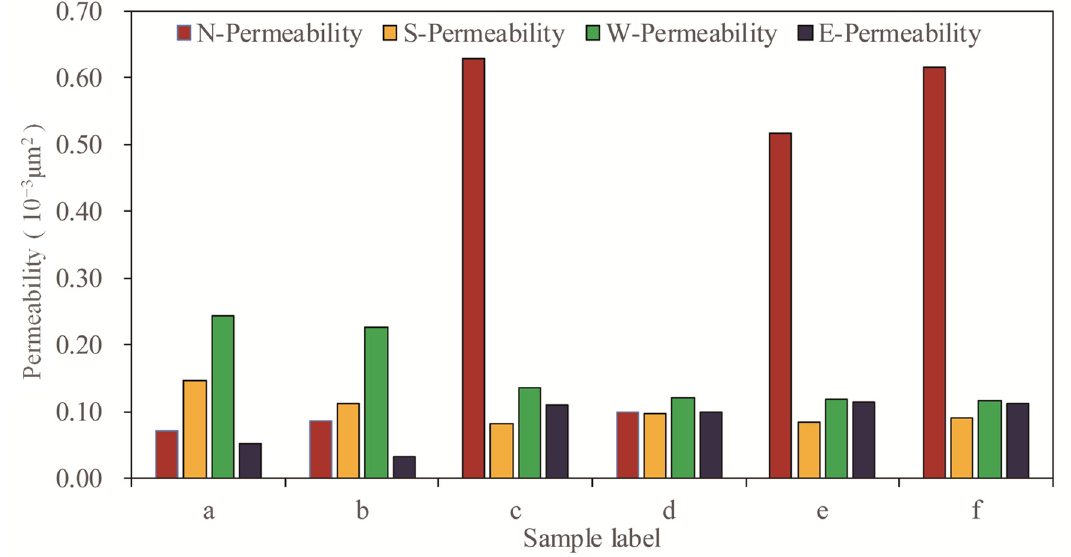
Figure 7. Simulation results of the four-dimensional permeability of samples a–f.